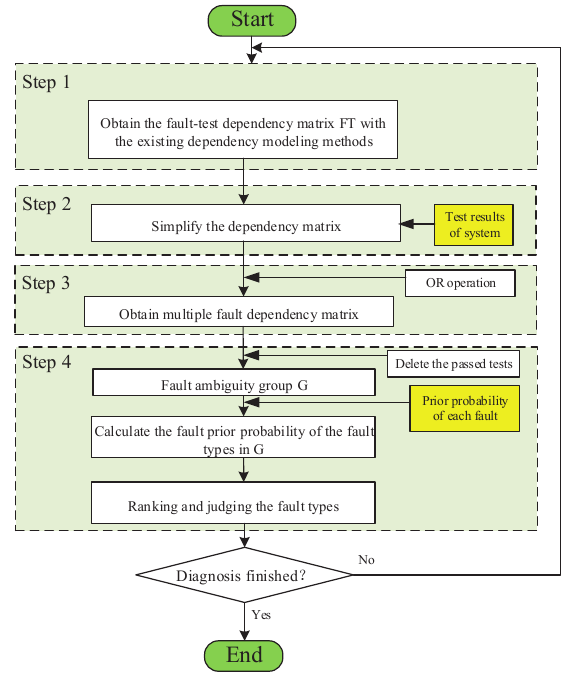
Figure 1. The flowchart of the dependency model-based multiple fault diagnosis